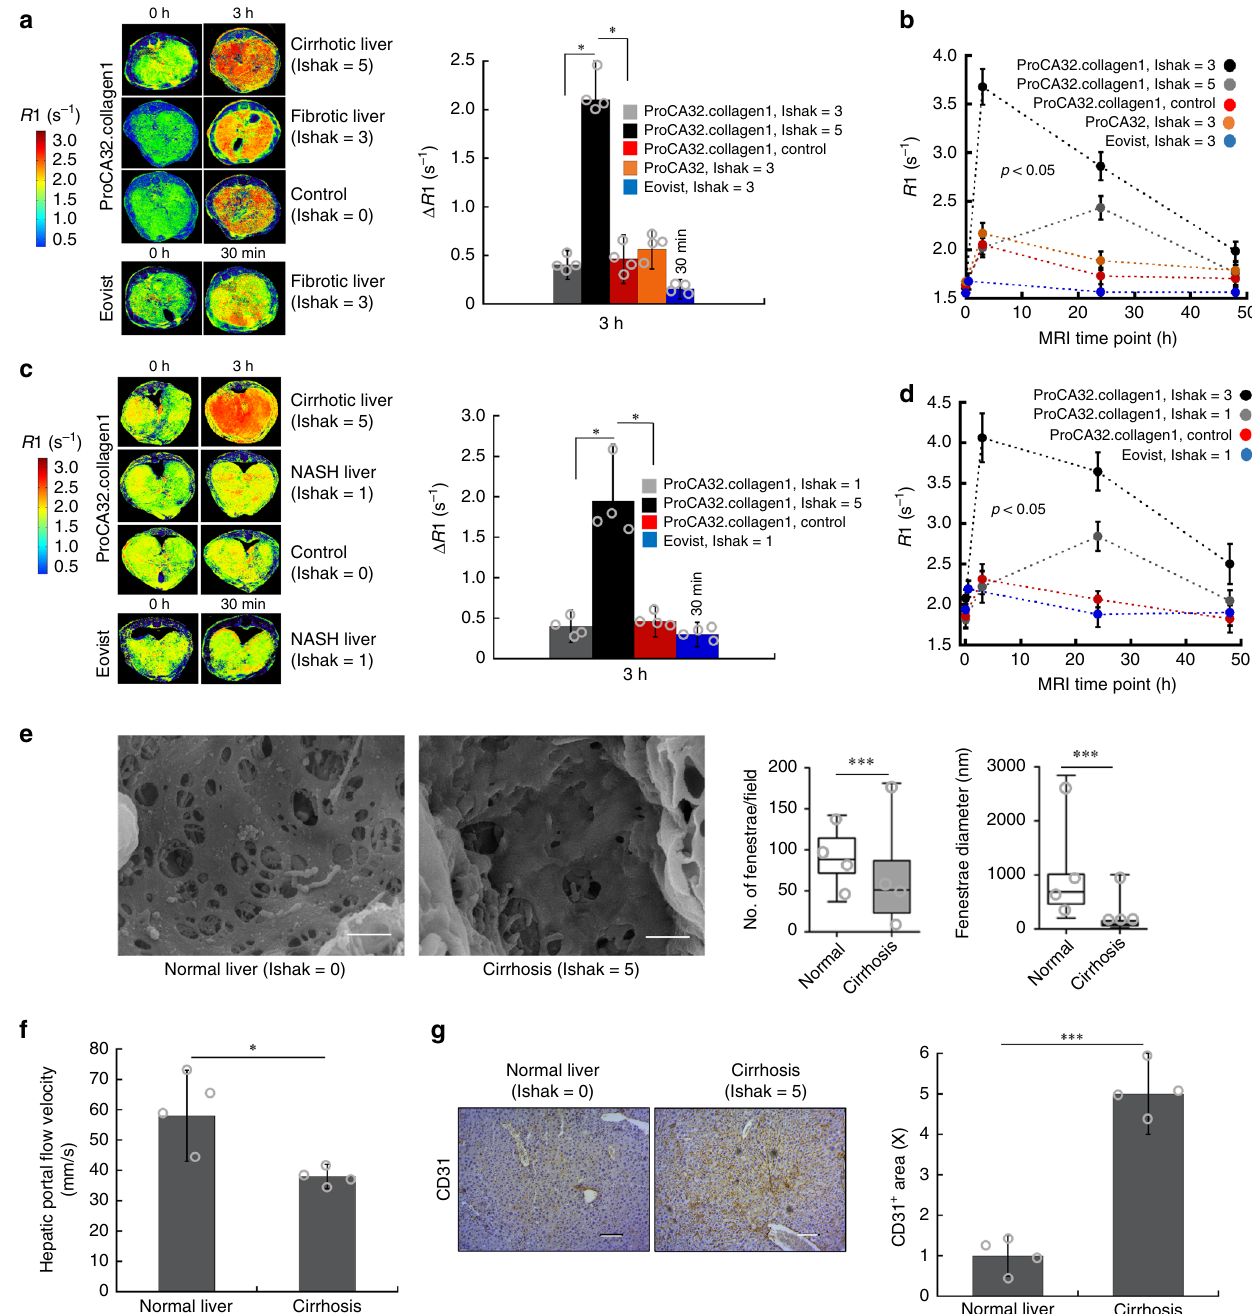
Fig. 4 Detection of portal hypertension during liver cirrhosis in TAA/alcohol- and NASH diet-induced cirrhosis. a R1 map and Δ R1 values of early-stage (Ishak stage 3 of 6), late-stage (Ishak stage 5 of 6), and normal liver (Ishak stage 0 of 6) before and 3 h after injection of ProCA32.collagen1 and Eovist (30 min) in TAA/alcohol model. b R1 changes of liver over different MRI time points after injection of ProCA32.collagen1, ProCA32, and Eovist in TAA/ Alcohol model ( P < 0.05, paired student ’ s t test). c R1 map and Δ R1 values of NASH (Ishak 1 of 6), late-stage (Ishak stage 5 of 6), and normal liver (Ishak stage 0 of 6) before and 3 h after injection of ProCA32.collagen1 and Eovist (30 min) in NASH diet model. d R1 changes of liver over different time points after injection of ProCA32.collagen1 and Eovist in NASH diet model ( P < 0.05, paired student ’ s t test). e Representative SEM images of sections from mice with late-stage liver fi brosis in TAA/alcohol model. Quantitation of number and size of fenestrations of liver sinusoids in mice with late-stage liver fi brosis measured by manually counting/measuring number and the diameters of fenestration in the SEM images (scale bar, 500 nm). f Velocity of portal vein blood fl ow as measured by Doppler ultrasound imaging shows high-portal hypertension detected at 3 h after injection of ProCA32.collagen1 in late-stage liver fi brosis in TAA/alcohol model. g Representative images of IHC stains of CD31 and quantitation of CD31 IHC stains of liver tissue in mice with late- stage liver fi brosis in TAA/alcohol model con fi rming intrahepatic angiogenesis. scale bar, 100 µ m; * P < 0.05, *** P < 0.001, unpaired two-tailed student ’ s t test; all data are represented as mean ± SD, n = 4 biologically independent animals in each